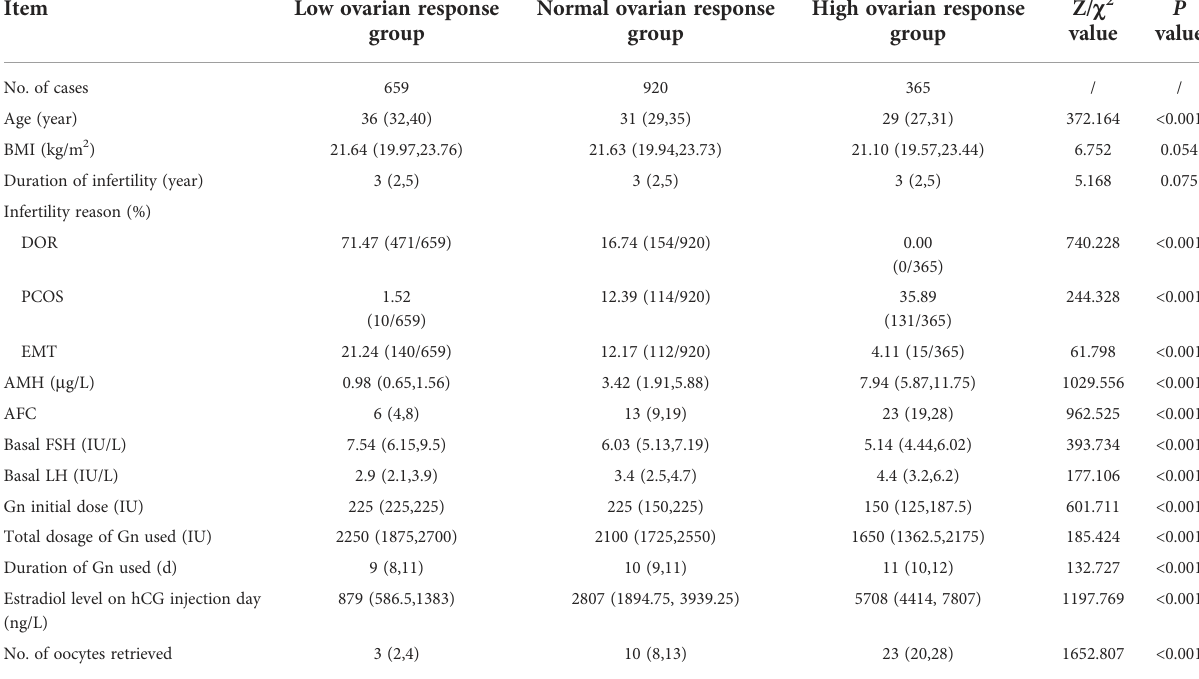
TABLE 1 Comparison of baseline data of patients with different ovarian